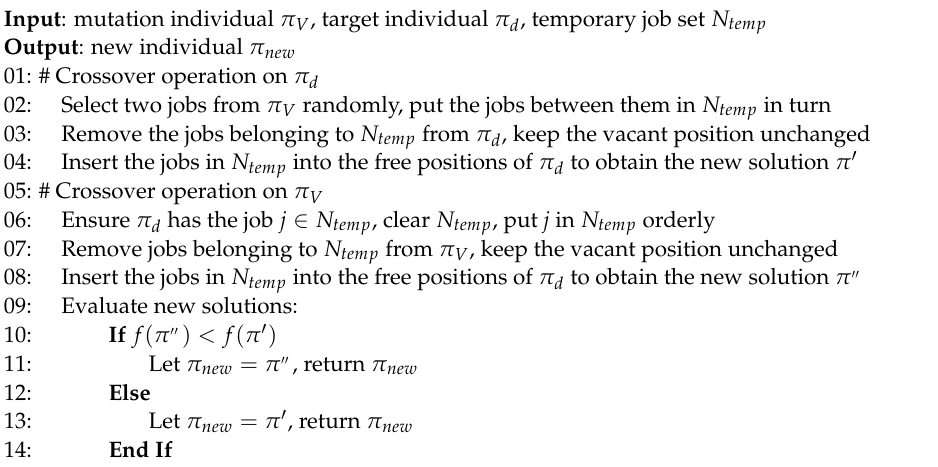
Algorithm 3 Crossover